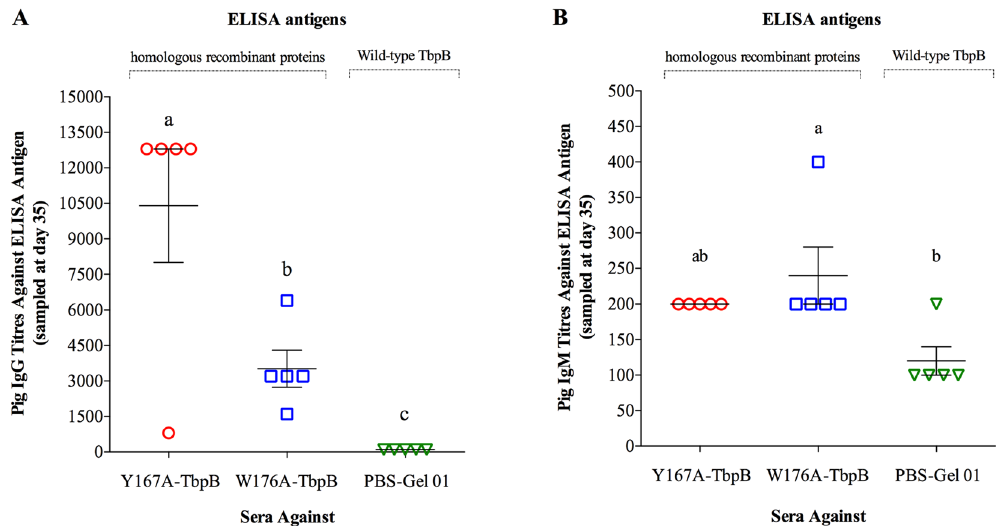
Figure 3. Antibody titres just prior to challenge (day 35). Sera collected at day 35 were titrated by two-fold serial dilution and assessed by indirect ELISA. ( A ) Titres of total sera IgG and ( B ) titres of total sera IgM. Different letters indicate significant differences (p < 0.05) between the different groups.